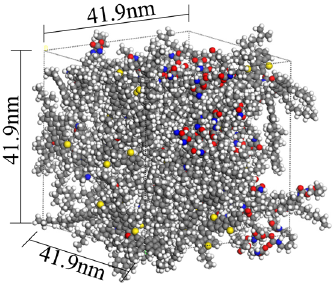
Figure 5: Molecular model of PU - modi fi ed asphalt.